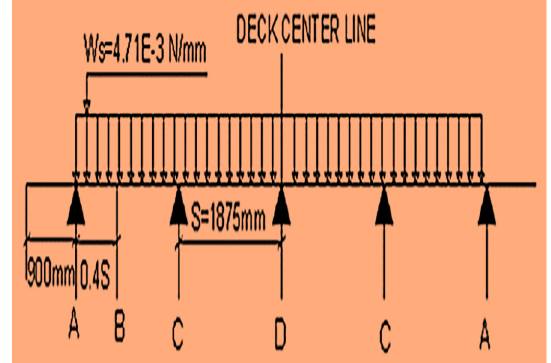
FIG. 4: TYPICAL DEAD LOAD PATTERN DUE TO DECK SLAB IN CASE OF T BEAM GIRDER